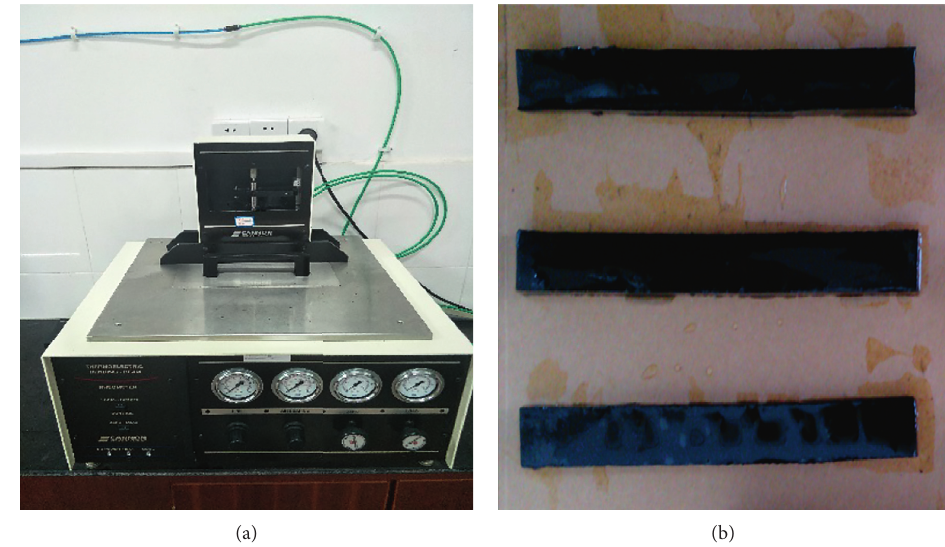
Figure 3: BBR test. (a) BBR equipment (CANNON). (b) Test specimen.